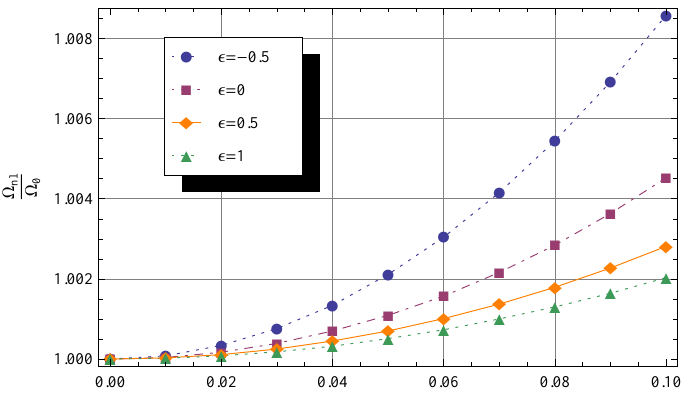
Figure 2. Frequency ratio Ω nl / Ω 0 for different values of η and (cid:101) . The other parameters are q 1 = 1, q 2 = 1, λ = 0, K R = 0, and K T =